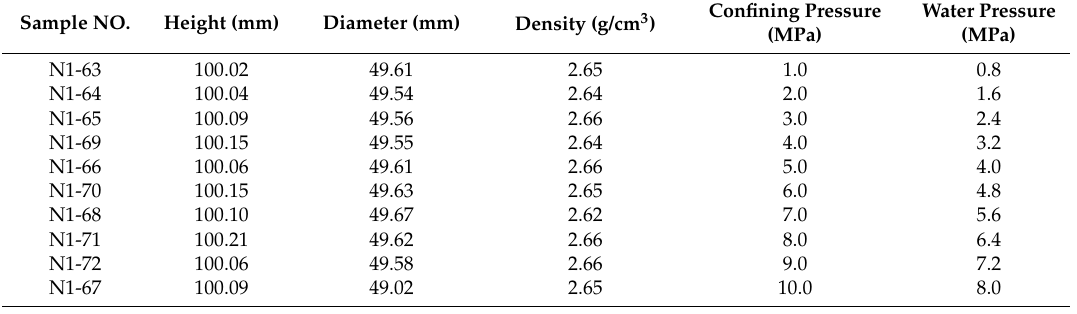
Table 2. Design for the tests under different confinements and water pressures.